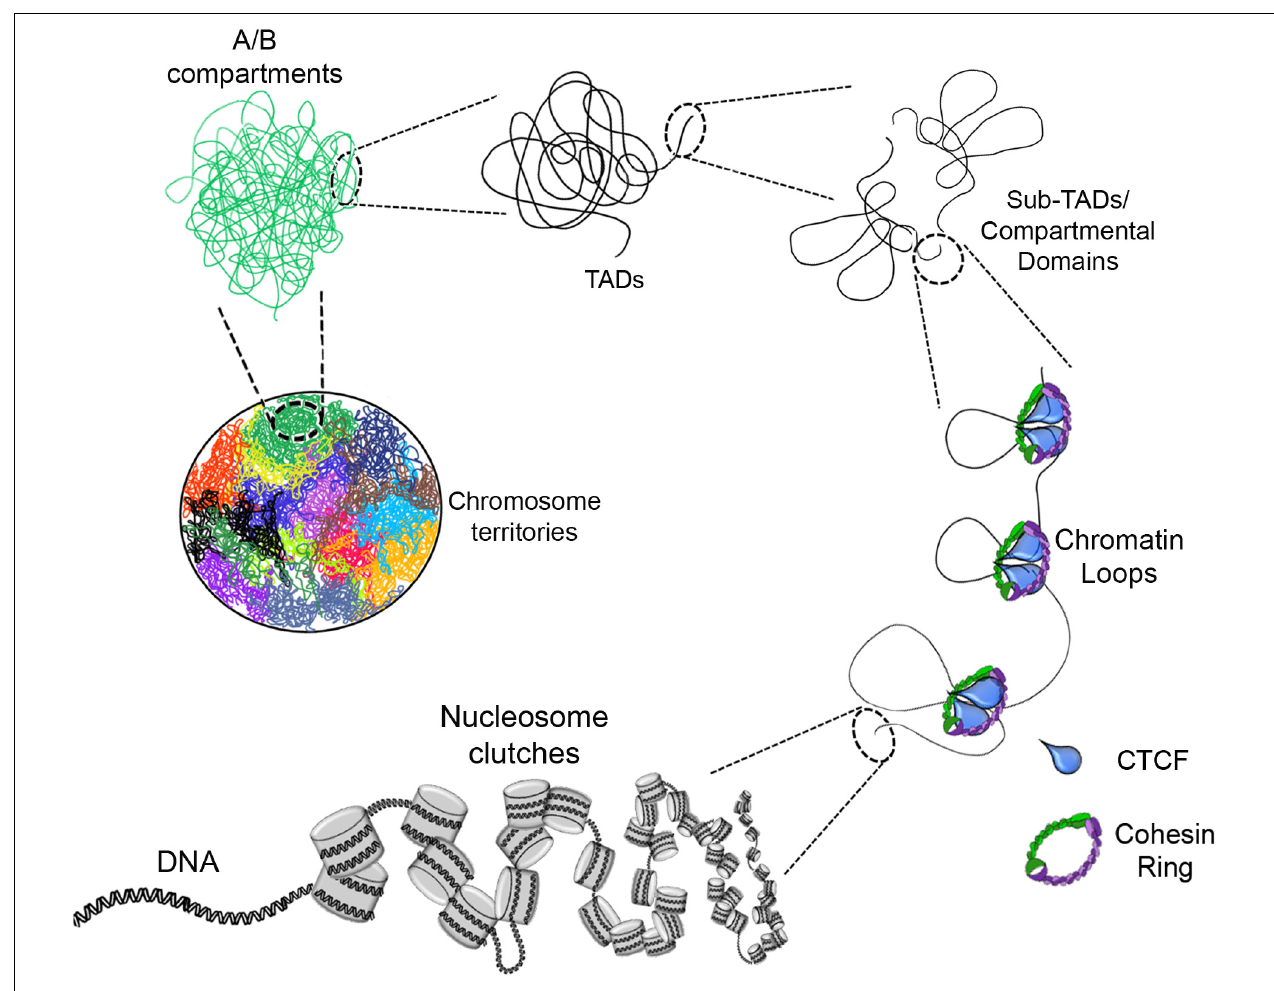
FIGURE 1 | Eukaryotic chromatin organization. The DNA interacts with histone octamers and aggregates forming nucleosome clutches. In the next level of compaction are the chromatin loops which are formed by loop extrusion and in a greater extent stabilized by CTCF and the cohesin ring. Chromatin loops are the base of compartmental domains, sub-TADs and TADs which range from ten of kb to Mb structures with delimited boundaries and high-rate interactions inside of these domains. A/B compartments is the next level, where can be determined by gene content, epigenetic marks, DNase hypersensitivity and nuclear localization. Finally, there are the chromosome territories which are the localization of each chromosome inside the nucleus (each color represents a different